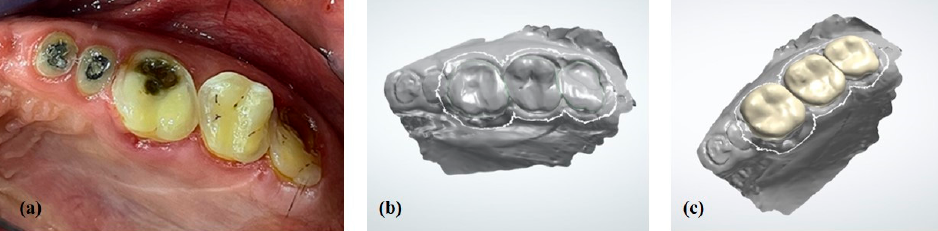
Figure 8 . Onlays in maxillary posterior segment 1: ( a ) Occlusal preparations; ( b ) digital cast; ( c ) design of onlays.